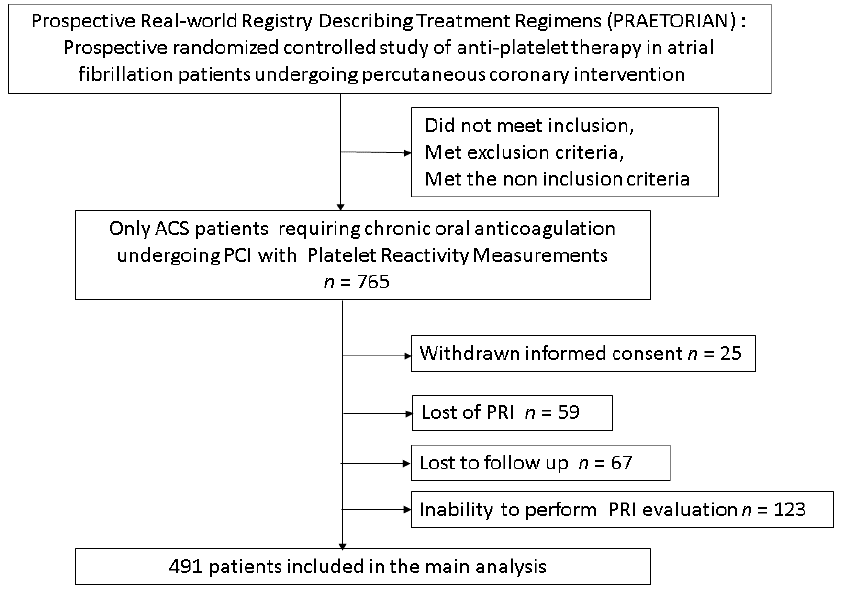
Figure 1. Flow-chart. ACS: acute coronary syndrome; PCI: percutaneous coronary intervention; PRI: platelet reactivity inhibition. Table 1. Baseline characteristics for patients with six months follow-up ( N = 491).